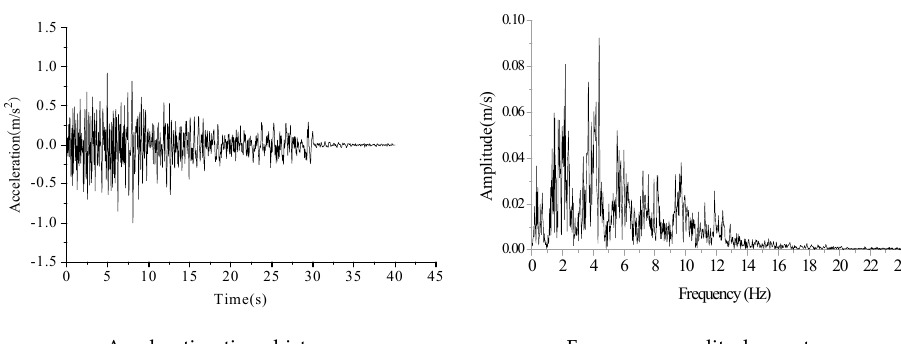
Figure 11. Taft motion in the horizontal direction after inversion.